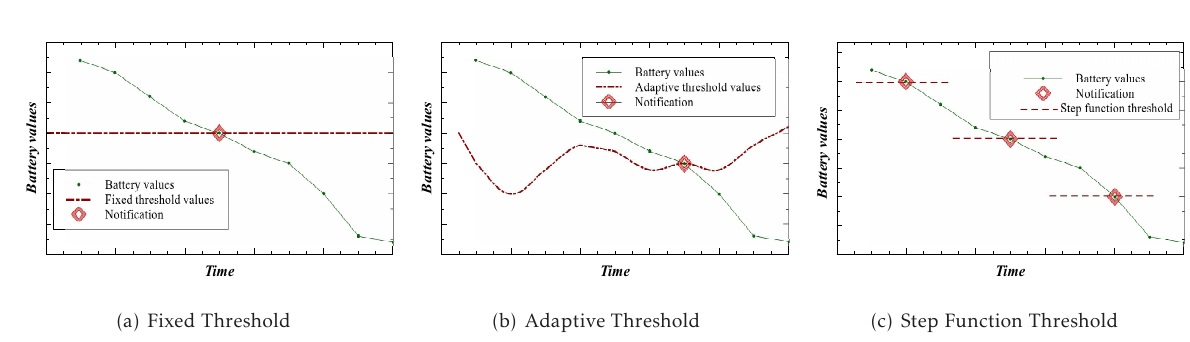
Figure 4. Threshold calculation for the tendency